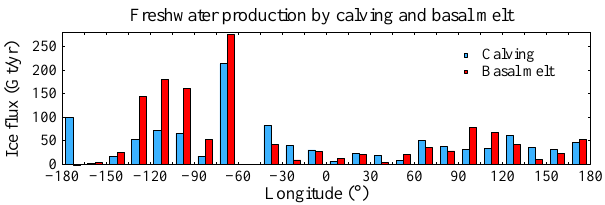
Figure 14. Freshwater flux (Gtyear − 1 ) from Antarctic ice shelves based on data of Rignot et al. (2013), integrated here into intervals of 15 ◦ of longitude. Depoorter et al. (2013) data yield a similar